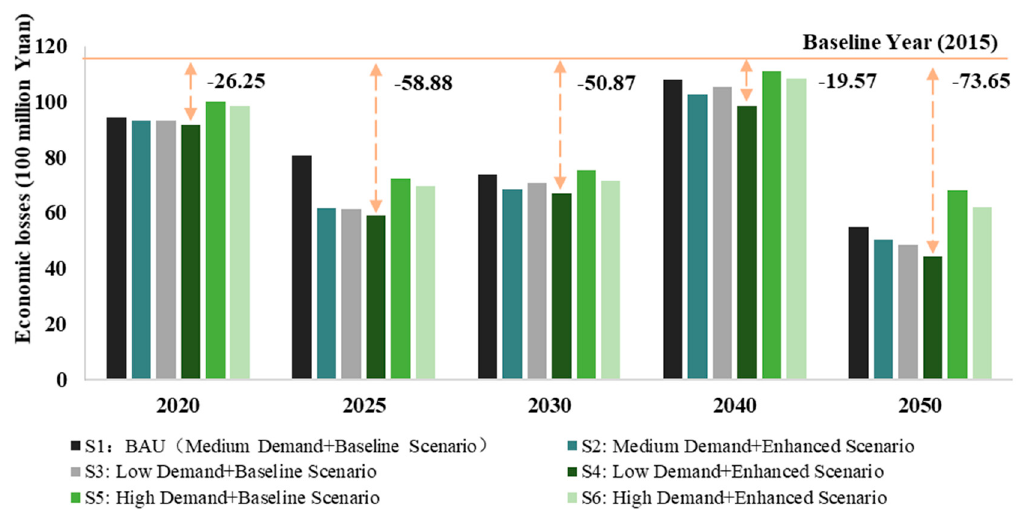
Figure 7. Health economic losses of PM 2.5 emissions under different scenarios in the steel sector.